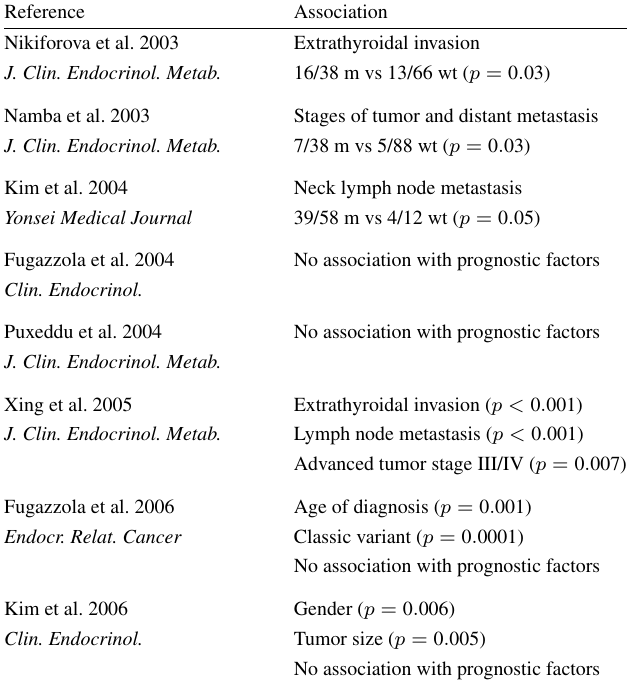
Association of the BRAF T1799A mutation with prognostic